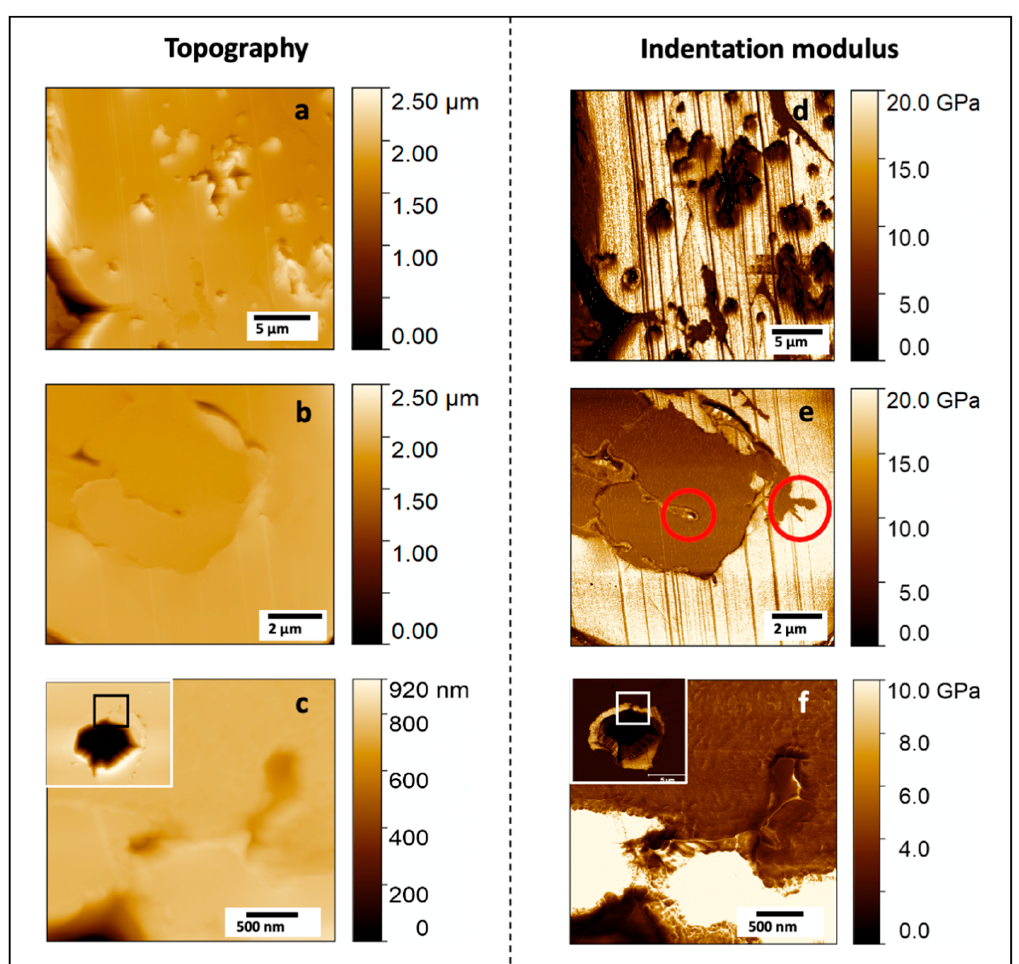
Figure 5. Surface topography ( a – c ) and indentation modulus mapping ( d – f ) of specific degraded areas. ( a , d ) are details of some fibres randomly degraded in G layers as typical degradation of soft-rot fungi; ( b , e ) focus on some typical degradation marks found in flax fibres, and red circles highlight the presence of bacteria and a probable fungal mycelium; ( c , f ) focus on a tunnel between inner and outer layers of the cell with a fungal mycelium that has grown in the exterior of the fibre and macrofibrils of the cell that are fragmented in packets with a low indentation modulus.